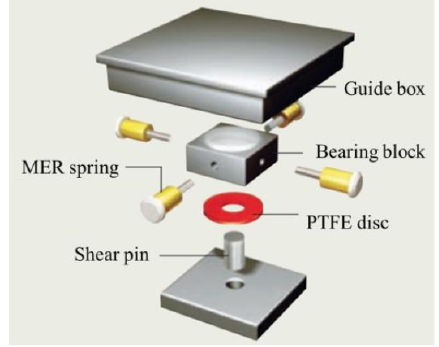
Figure 2. Composition of Eradi-Quake System (EQS).